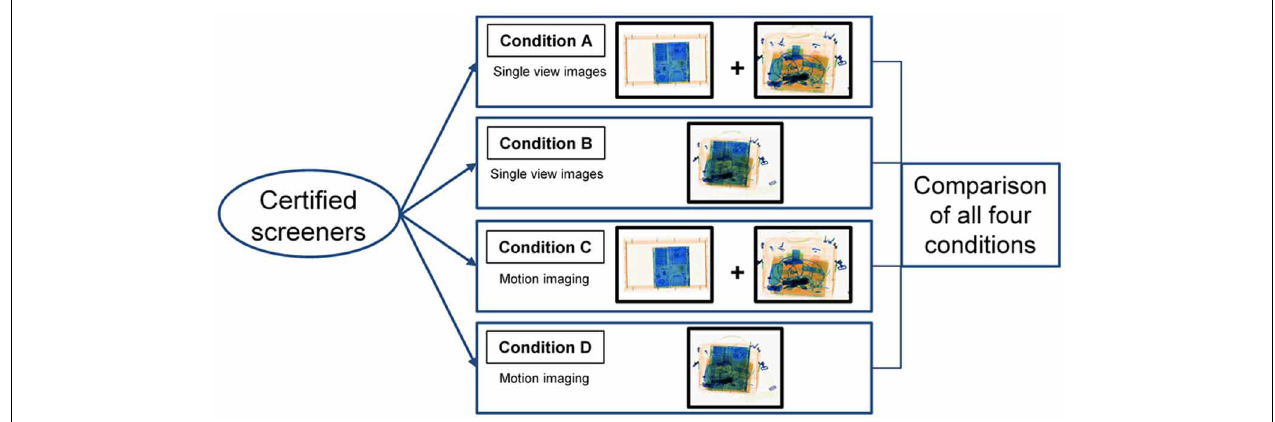
FIGURE 2 | Experimental design (between-participants) for the comparison of the four different